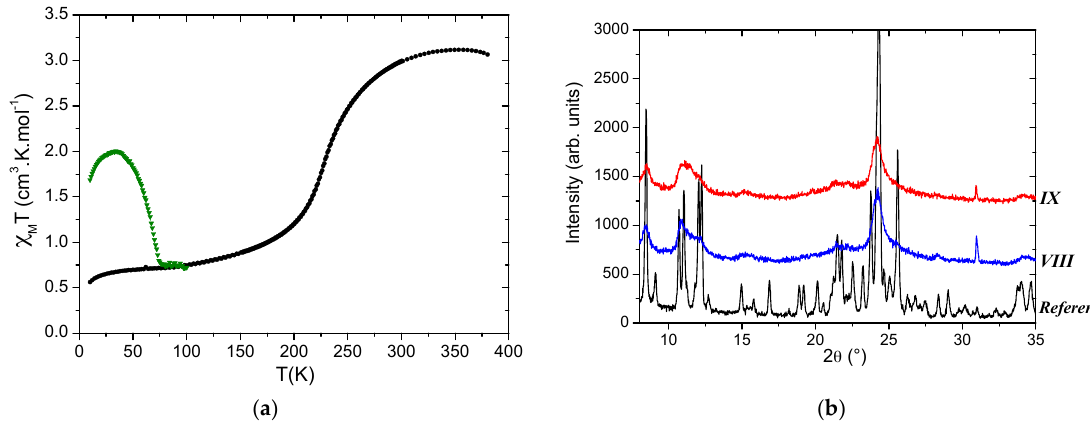
Figure 9. Physical characterizations showing ( a ) χ M T as a function of temperature including LIESST effect (green) of batches VIII and IX and ( b ) the PXRD patterns of batches VIII (blue) and IX (red), including the reference one for [Fe(bpp) 2 ](NCS) 2 ·2H 2 O. The latter is known to crystallize in the triclinic unit-cell with a = 8.302(6) Å; b = 8.446(6) Å; c = 21.531(13) Å, α = 78.78(5)°, β = 82.50(5)° and γ = 89.85(4)° [48]. Table 4. Elemental analysis (CHN) for batches VIII and IX with the expected values for [Fe(bpp) 2 ](NCS) 2 · 2H 2